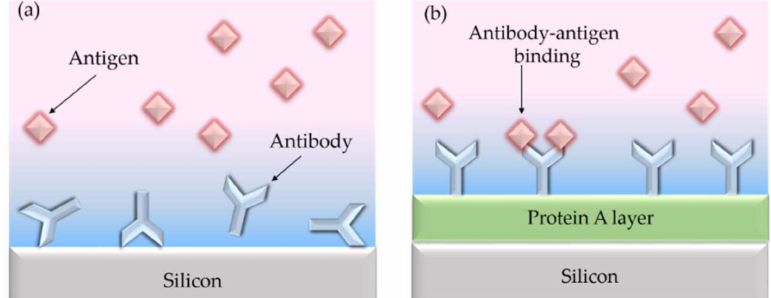
Figure 6. ( a ) The antibody receptors are usually randomly oriented on the silicon surface when they are directly immobilized using physical adsorption. ( b ) Using a protein A layer leads to properly oriented antibody receptors. Reproduced from Ref. [61] (CC BY